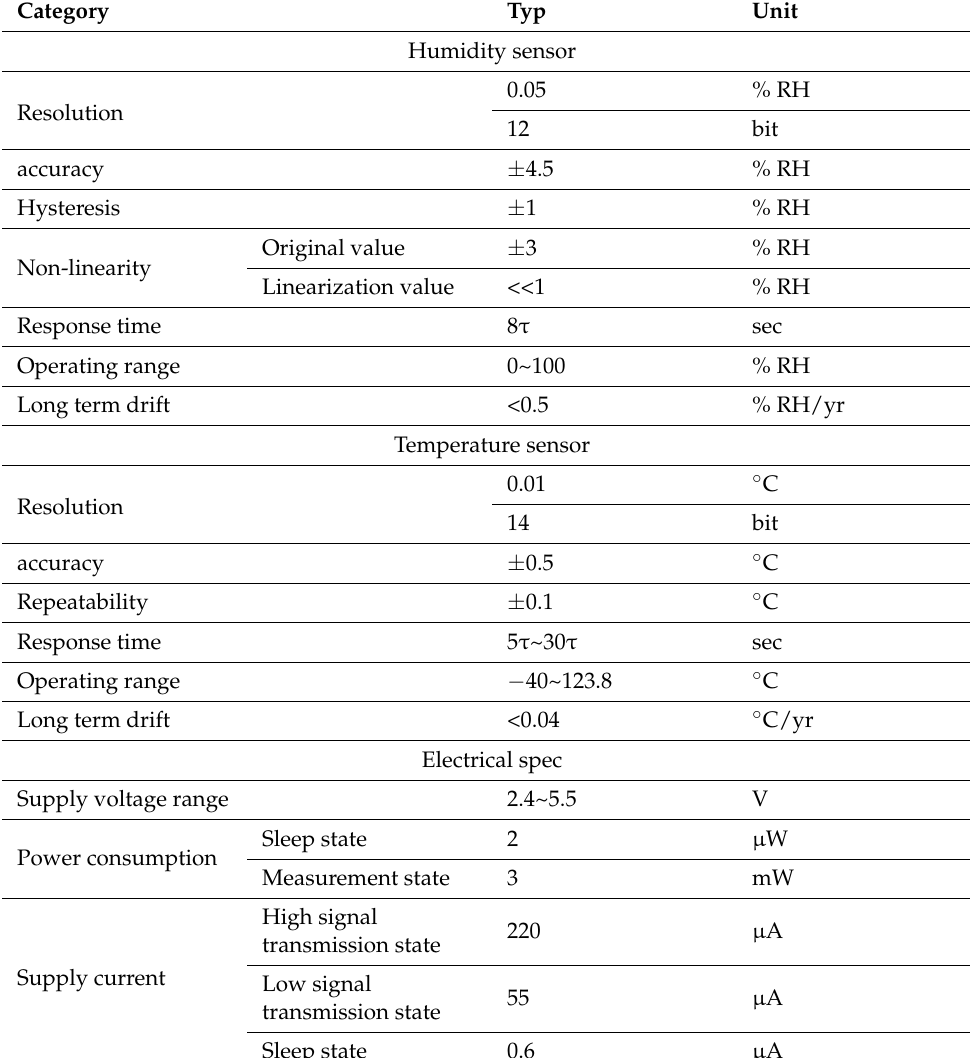
Table 1. SHT10 temperature and humidity sensing element—humidity